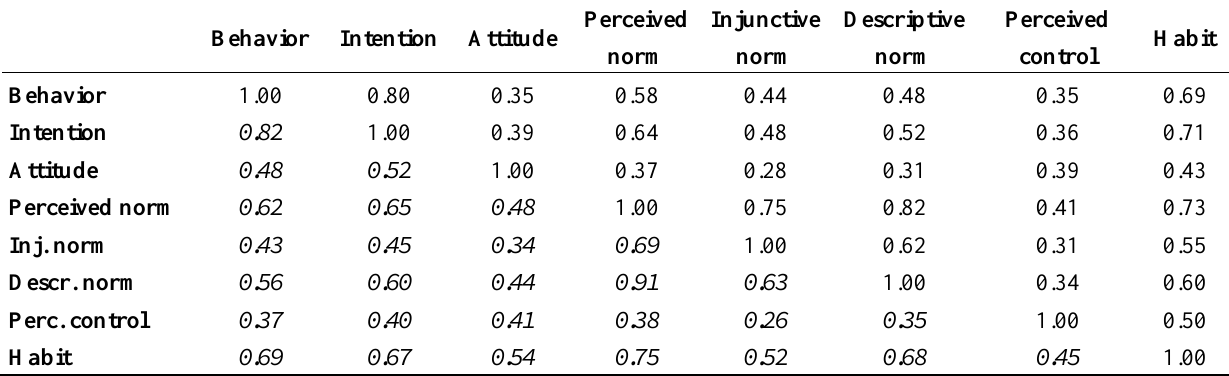
Table 5. Teleconferencing: correlations between latent